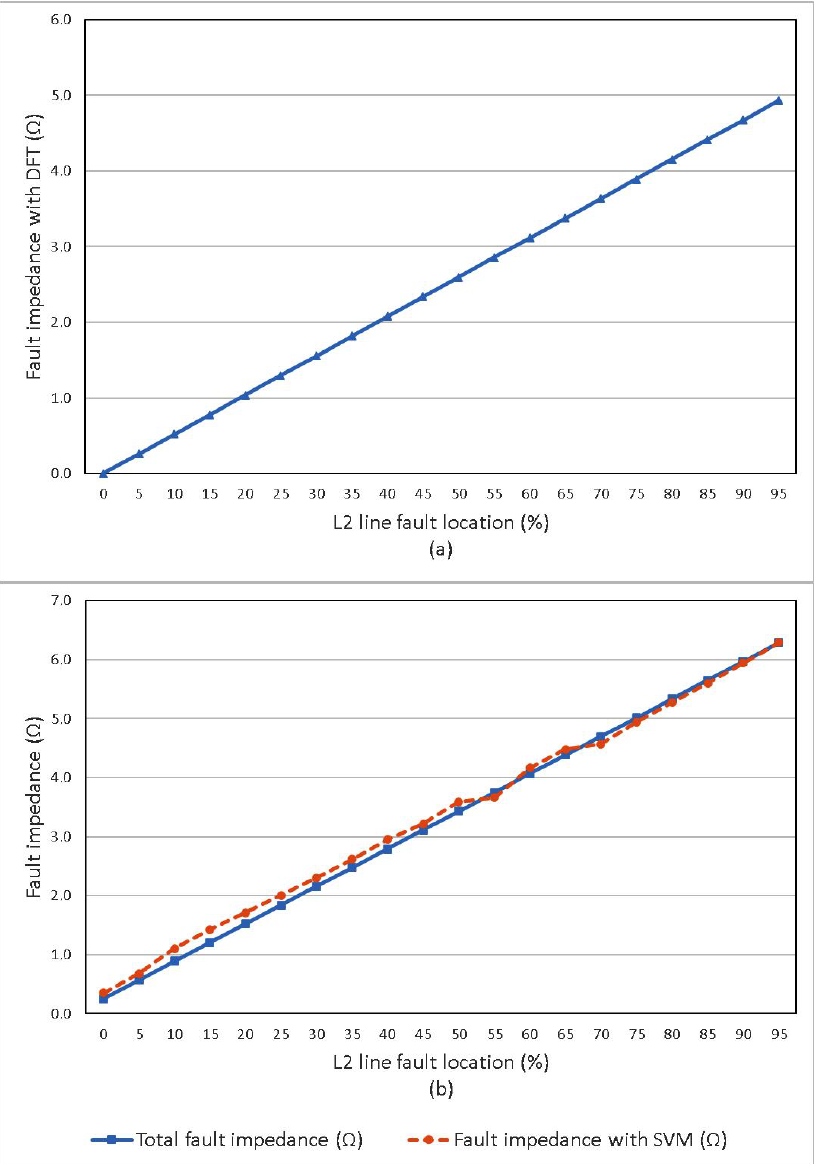
Figure 12. Single phase–ground faults. ( a ) Fault impedance with DFT-fault location. ( b ) Total fault impedance and fault impedance with SVM-fault